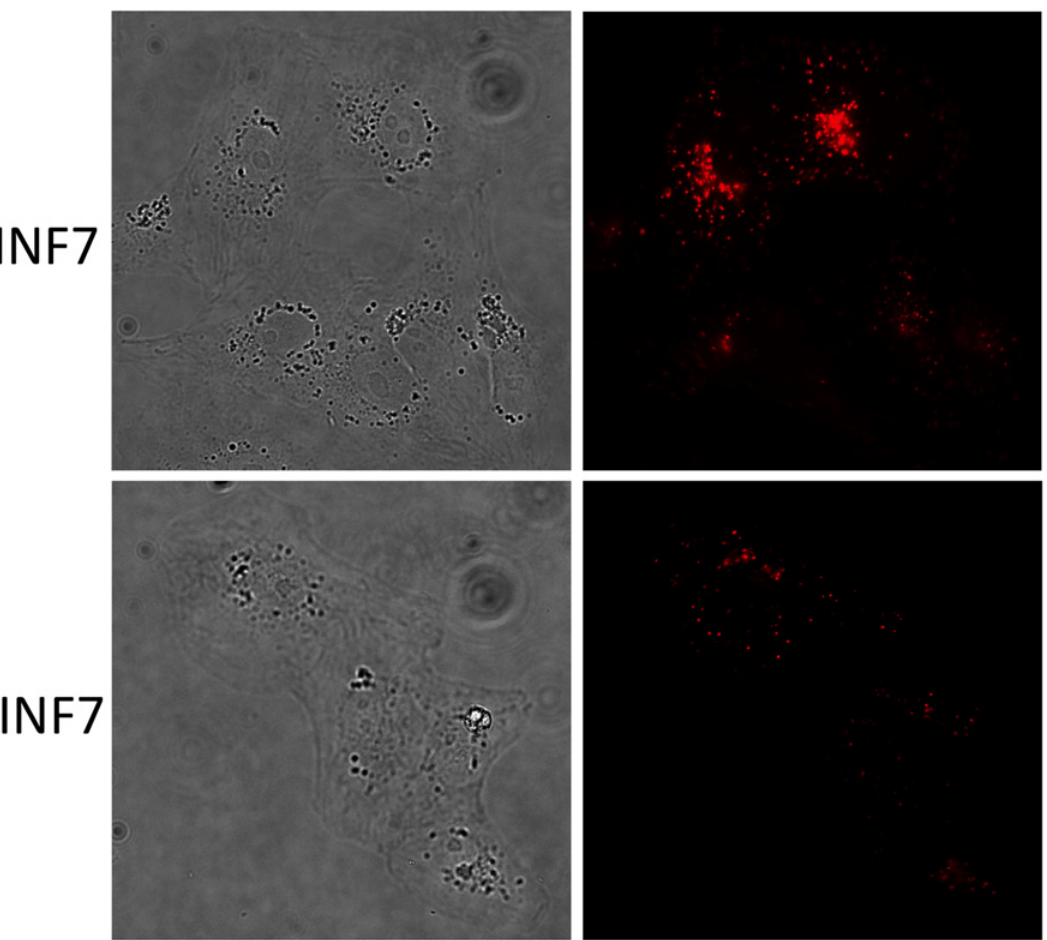
Fig 5. INF7 mediates release of endosomal SR into the cytosol. Liposomes containing SR with or without INF7 were incubated with CV1 cells for 1 hr, washed to remove un-endocytosed liposomes, and allowed to incubate without liposomes for an additional 2 hr. SR remains confined in endosomes without INF7 (-INF7), but after release into the cytosol by INF7, SR is rapidly transported from the cytosol into the extracellular volume (+INF7) leading to much dimmer fluorescence in cells incubated INF7-containing liposomes. See main text for more detailed mechanistic